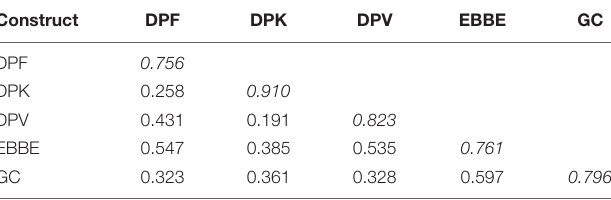
TABLE 4 | Direct, indirect, and total path